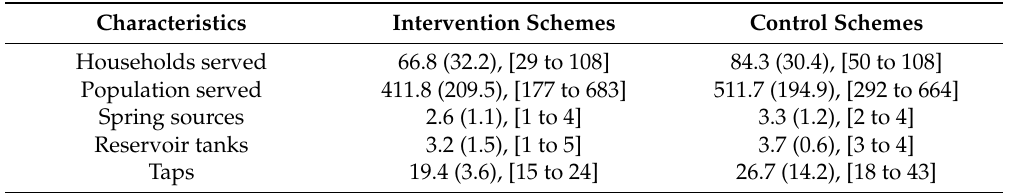
Table 3. Description of water supply schemes characteristics: mean (standard deviation),